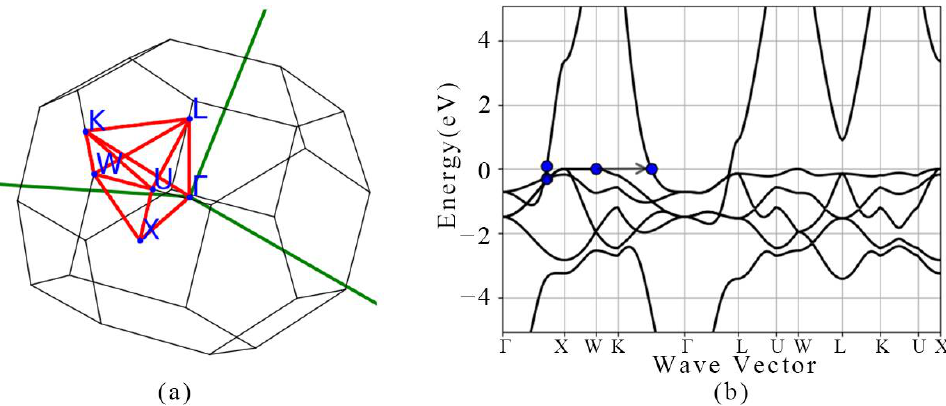
Figure 2. Band structure calculation results for Cu: ( a ) first Brillouin zone and K-point path; ( b ) energy band diagram of Cu.